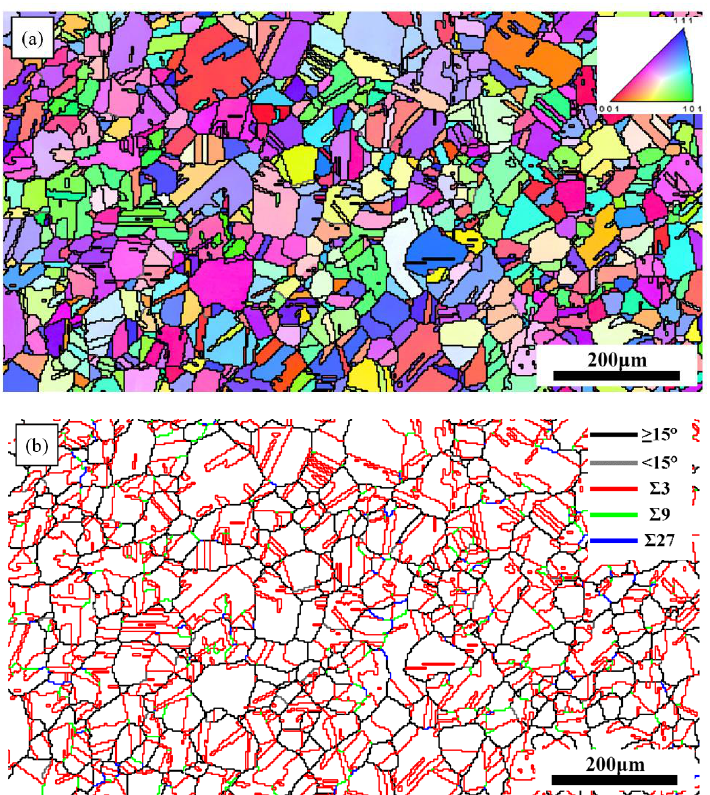
Figure 2. IPF map ( a ) and GBCD map ( b ) of the initial microstructure for the tested C276 superalloy.